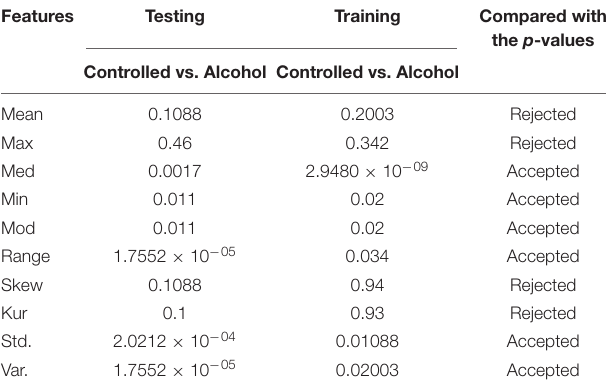
TABLE 1 | Feature set outcome of Experiment No. 1.